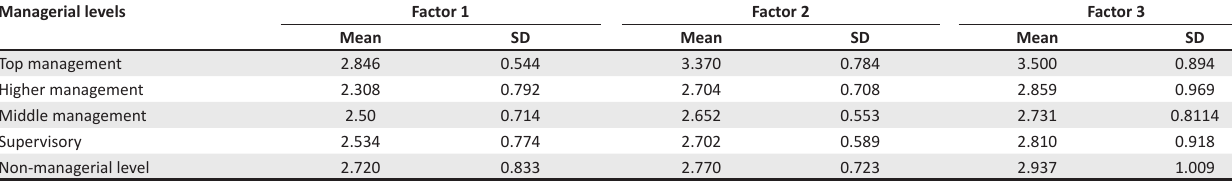
TABLE 13: Descriptive statistics for managerial levels.